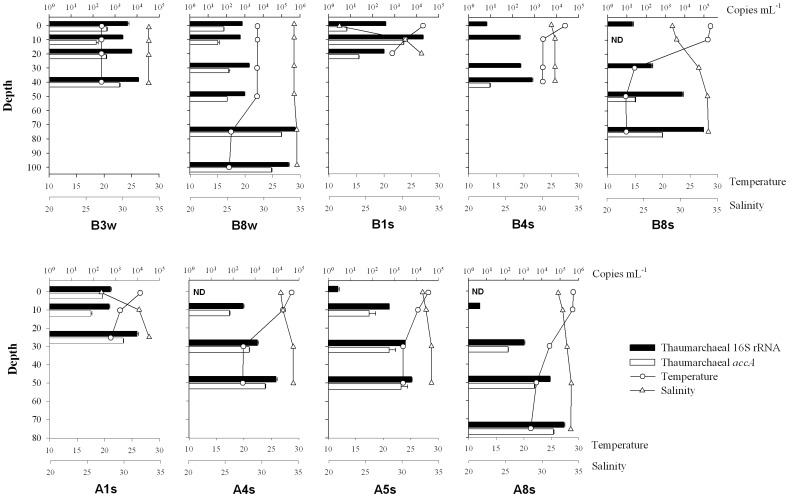
Depth profiles of temperature, salinity, and the abundance of thaumarchaeal 16S rRNA and accA genes in two autumn stations (B3w and B8w) and seven summer stations (B1s, B4s, B8s, A1s, A4s, A5s and A8s).Bars denote one standard deviation of the triplicate qPCR determination.